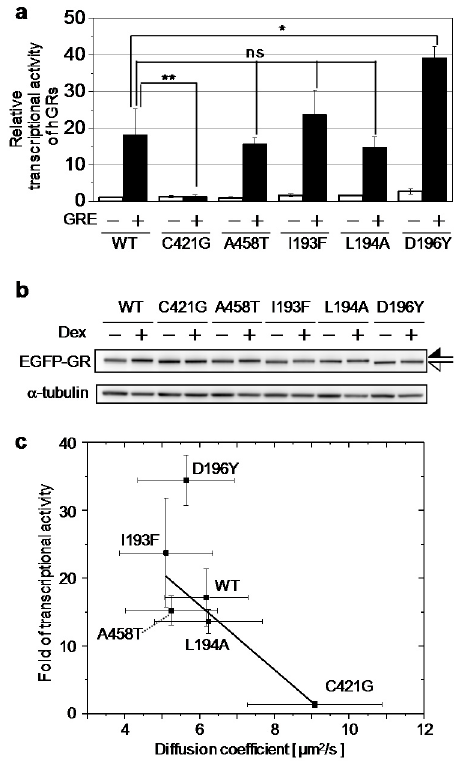
Figure 4. The relationship between the transcriptional activity and the diffusion coefficients of hGRs. ( a ) The relative transcriptional activities of hGR wild type and mutants were estimated by a luciferase assay using pGL4 (without GRE) and pGL4-GRE shown as open and solid bars, respectively. The relative transcriptional activity was calculated so that the normalized luciferase activity with an addition of 100 nM Dex was divided by the normalized luciferase activity with DMSO only. The mean and SD of fold transcriptional activity were obtained from three individual experiments. The transcriptional activity of EGFP-hGR C421G and EGFP-hGR D196Y were significantly smaller and larger than that of EGFP-hGR WT , respectively. *: p < 0.05, **: p < 0.001, ns: no significant differences (Student t -test); ( b ) the expression levels of EGFP-hGR wild type and mutants were estimated by a Western blot using anti-EGFP and anti- β -tubulin antibodies. The black arrow indicates the band shift of EGFP-hGR wild type and mutants except EGFP-hGR D196Y . The white arrow indicates the band shift of EGFP-hGR D196Y ; ( c ) the relationship between the diffusion coefficients (from RICS) and the transcriptional activities (from the luciferase assay) of hGR wild type and mutants. The error bars on the x - and y -axis indicate the standard deviation (SD) and standard errors (SEM), respectively. The solid line indicates the linear regression by least squares method, adjusted R 2 = 0.82.